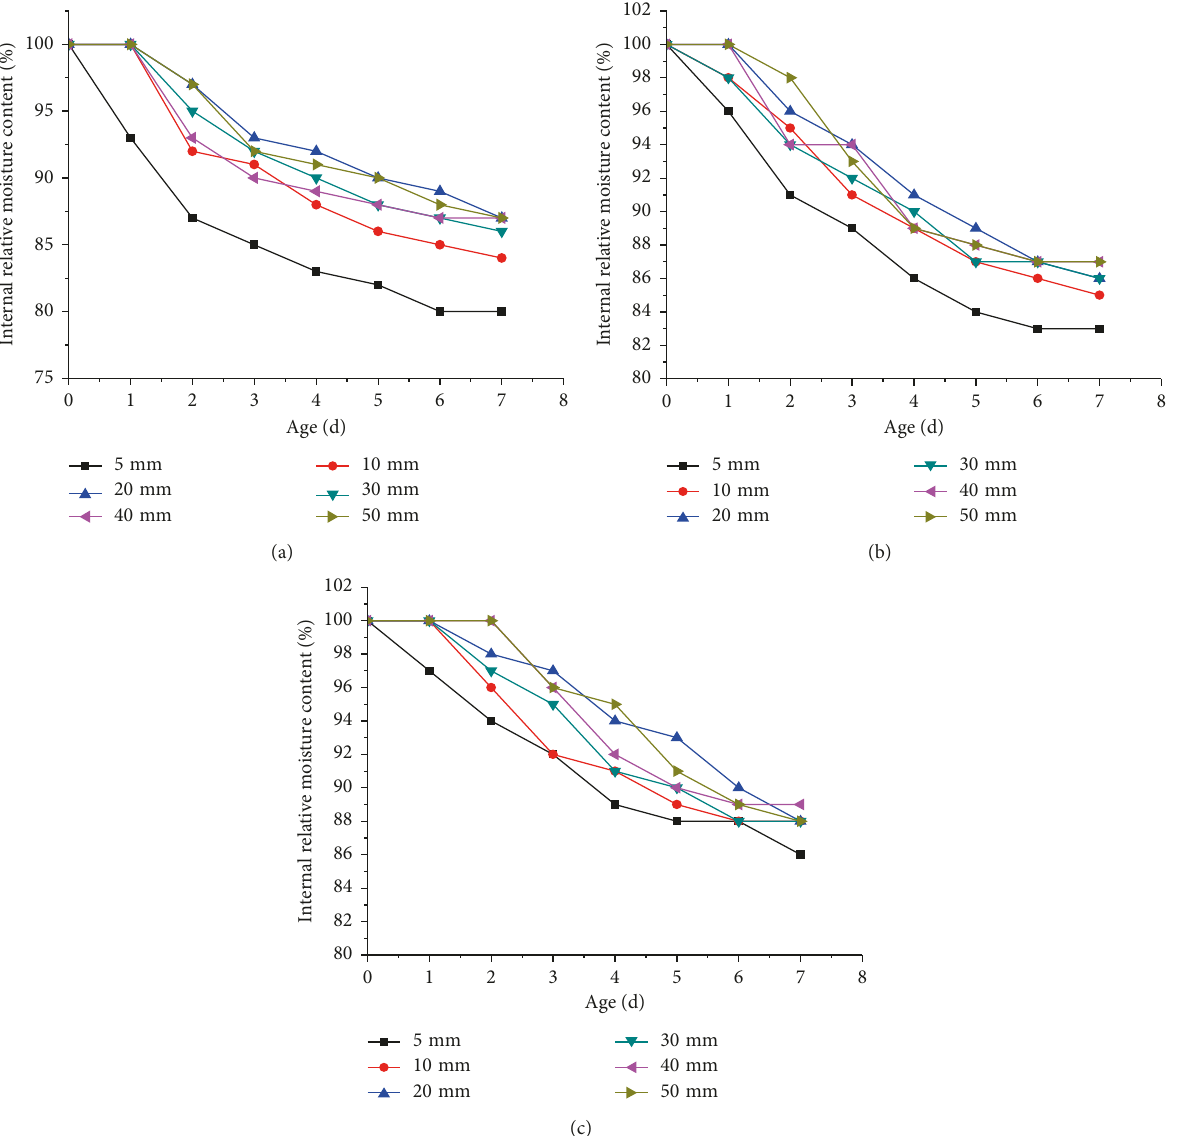
Figure 6: Internal relative moisture content of concrete under 20 ° C, 80% RH. (a) No CPF liner. (b) Lateral surfaces covered by CPF liner. (c) Three surfaces covered by CPF